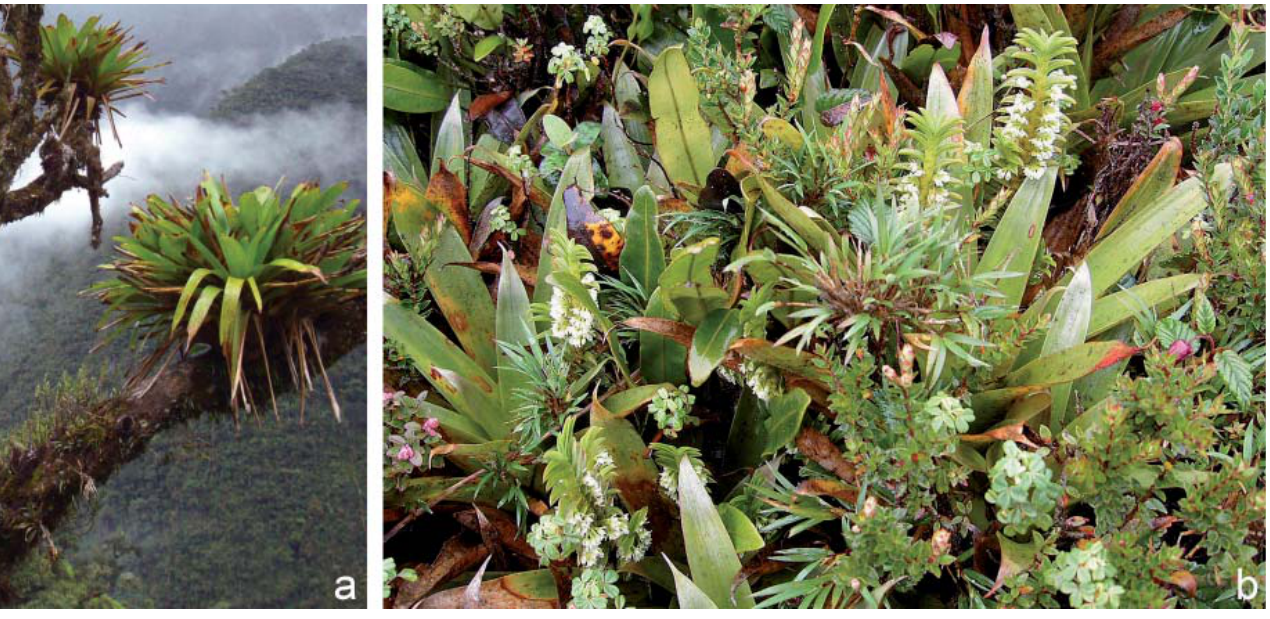
Figure 15: Small habitats such as epiphytic communities on trees (a) as well as slight level differences from the micro-relief in páramos (b) harbour a considerable number of herbaceous vascular plants and contribute additionally to enhanced species numbers (photos: M.